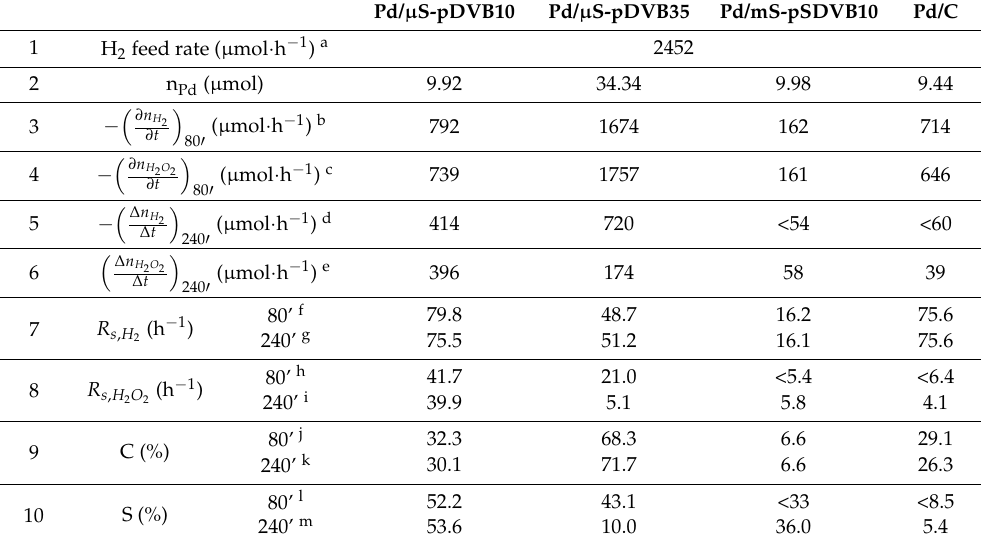
Table 3. Apparent and specific rates of H 2 consumption and H 2 O 2 formation and the respective conversions and selectivities over different